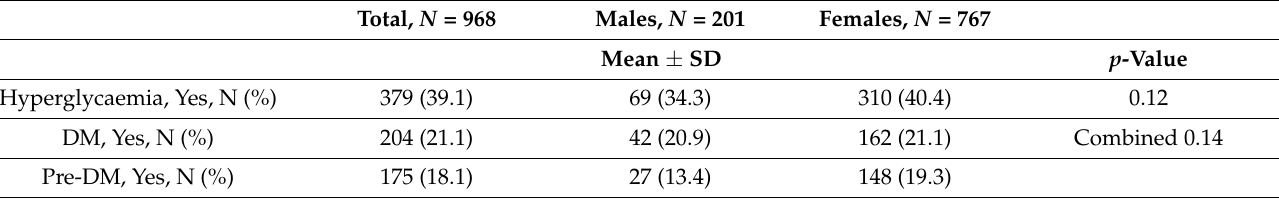
Table 1. Participant characteristics categorized according to